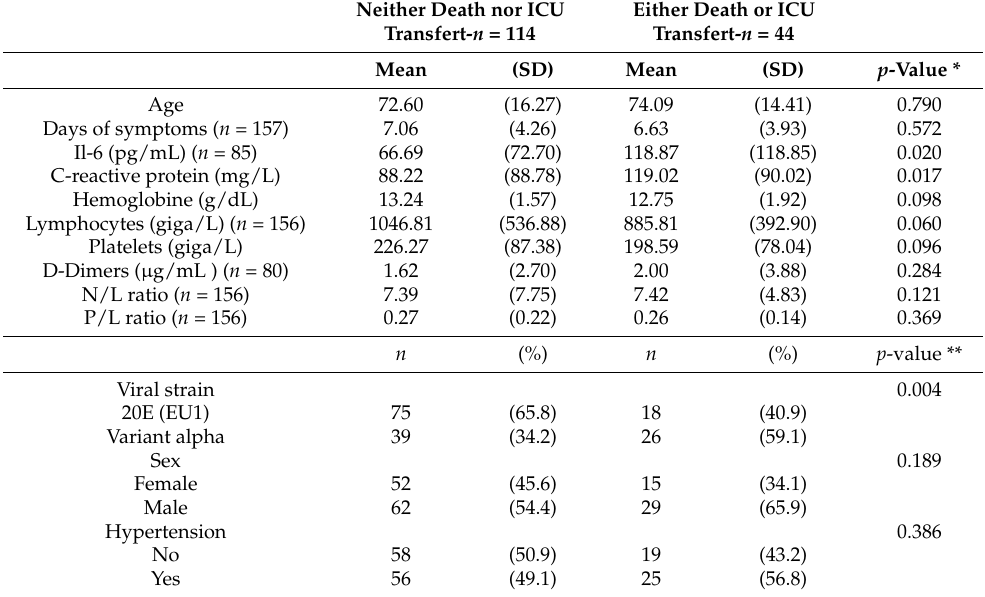
Table 2. Factors associated with the clinical